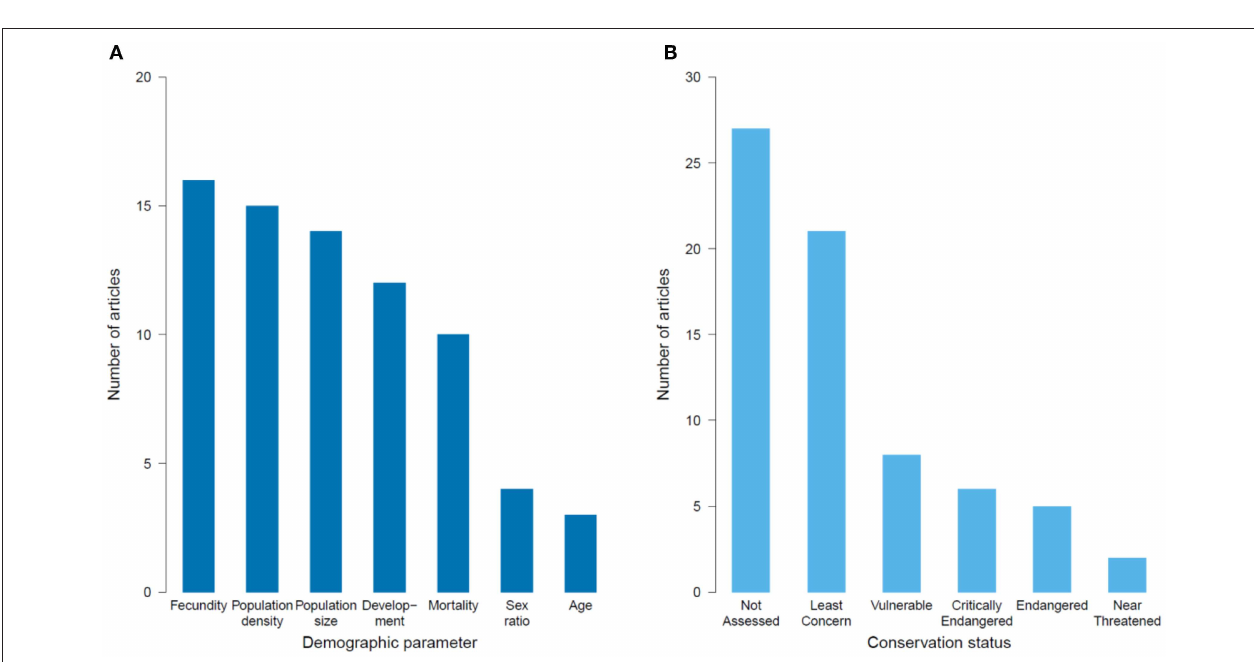
the impacts of habitat degradation on a single focal species, but two drew comparisons between two species (Winkler et al., 2011; Quevedo et al., 2013), and another compared seven species (Callens et al., 2011). Most articles examined the impact of